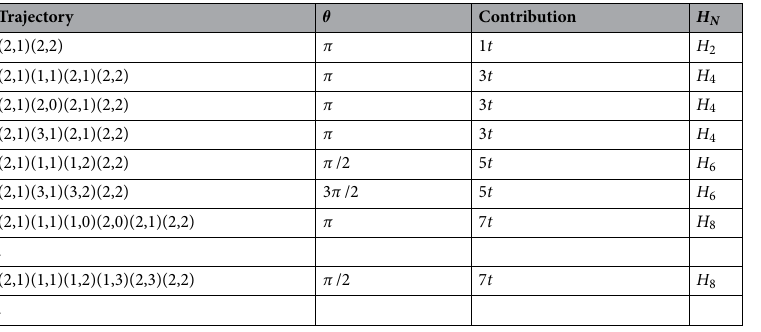
Table 1. Possible trajectories for a vacancy generated at (2,1) due to hopping by a tracer. The vacancy coalesces with the tracer again after taking ( N − 1 ) steps on the 2-dim. lattice shown in Eq. (4). The coalescence angle θ is measured from the direction of the initial hop by the tracer. Each trajectory contributes to the summation in Eq. (1) with weight P k corresponding to the energy E ∼ t t (only between nearest neighboring sites). Each trajectory is identified by the annealing simulation α → β = using the Hamiltonian H N